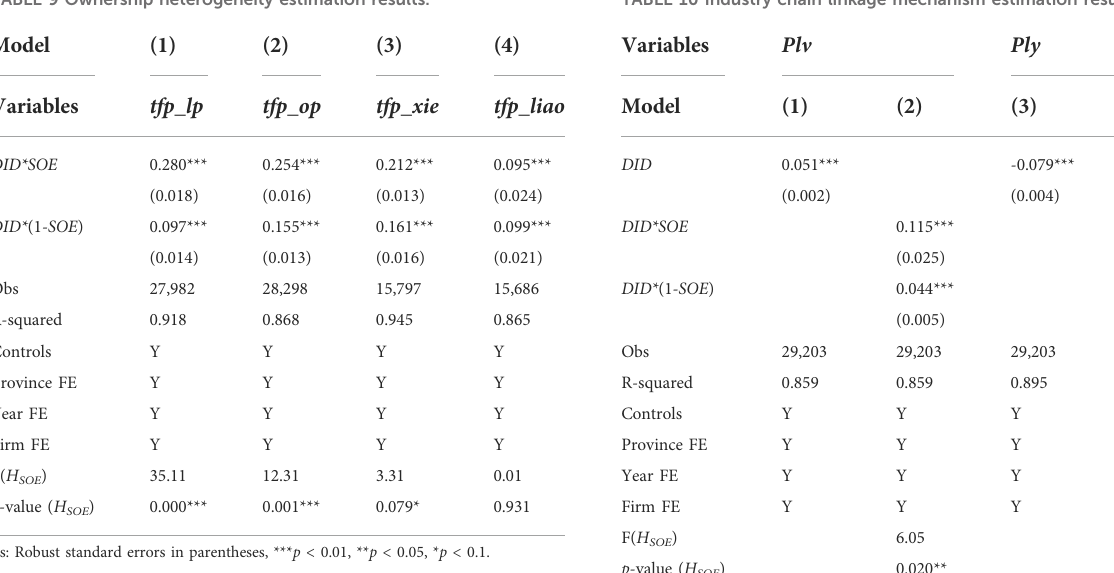
TABLE 9 Ownership heterogeneity estimation results. TABLE 10 Industry chain linkage mechanism estimation